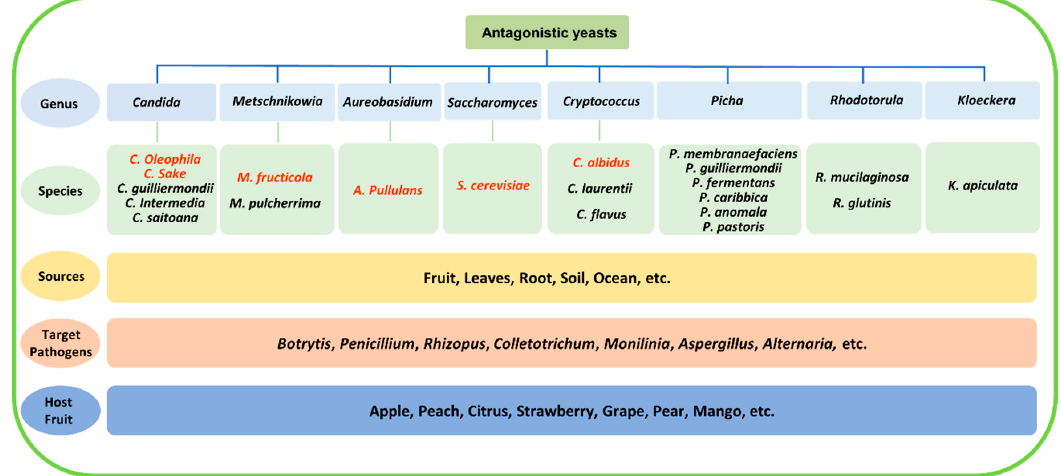
Figure 1. Representative antagonistic yeasts from various sources used for the management of postharvest decay. Species that have been already in commercial use are highlighted in red.